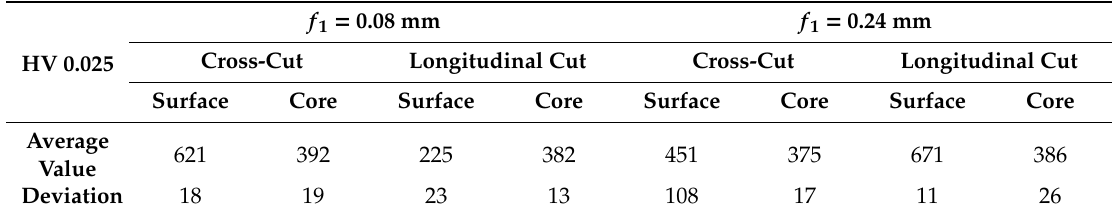
Table 3. Microhardness (HV 0.025) of fine and roughly turned samples with Ni coating deposition.